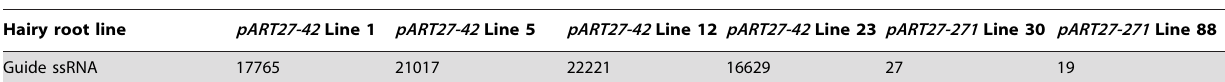
Table 1. Numbers of 16D10 small RNA reads observed from four pART27-42 and two pART27-271 transgenic hairy root lines.